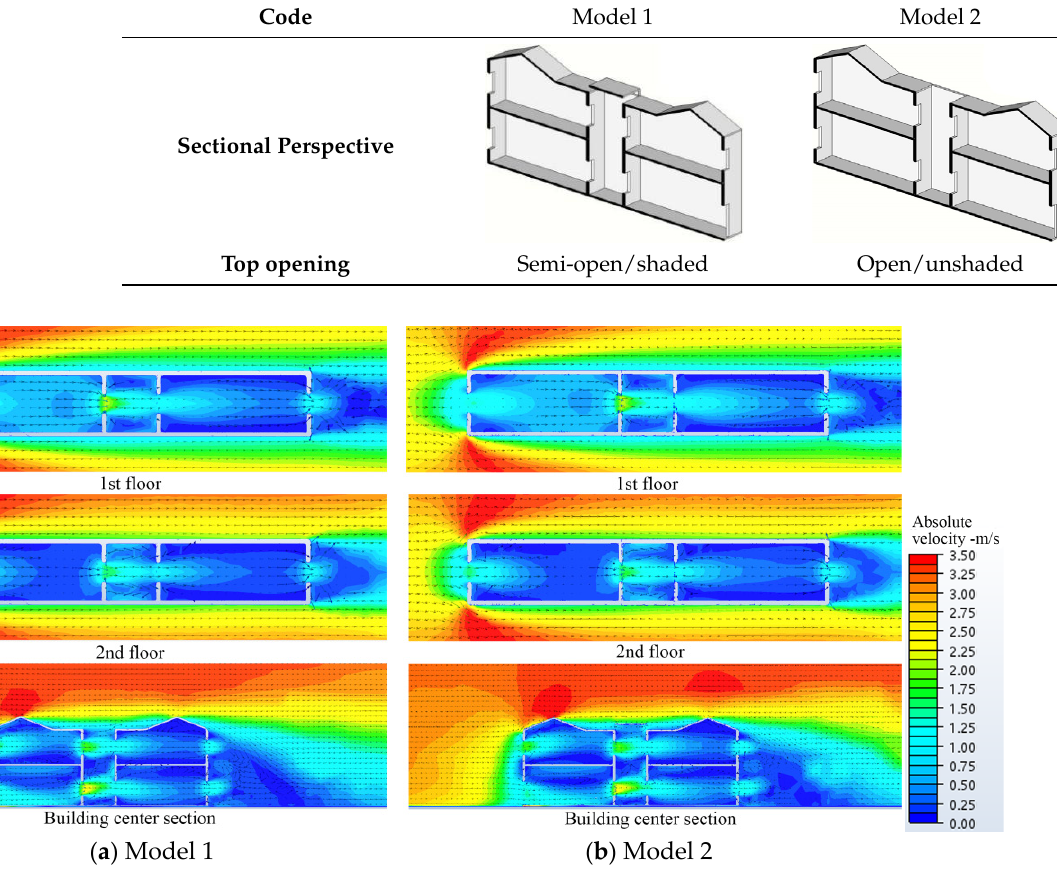
Figure 6. Simulated spatial distributions of V a in Models 1–2 at 12:00 at 1.2 m height on each floor. Table 4. Different top openings of the courtyard.